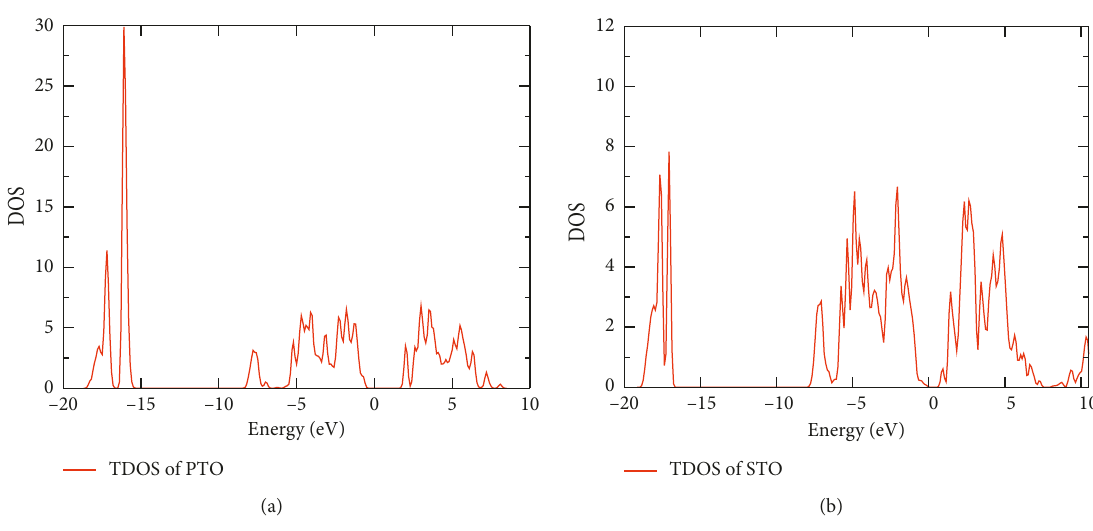
Figure 5: Total density of states of (a) PbTiO